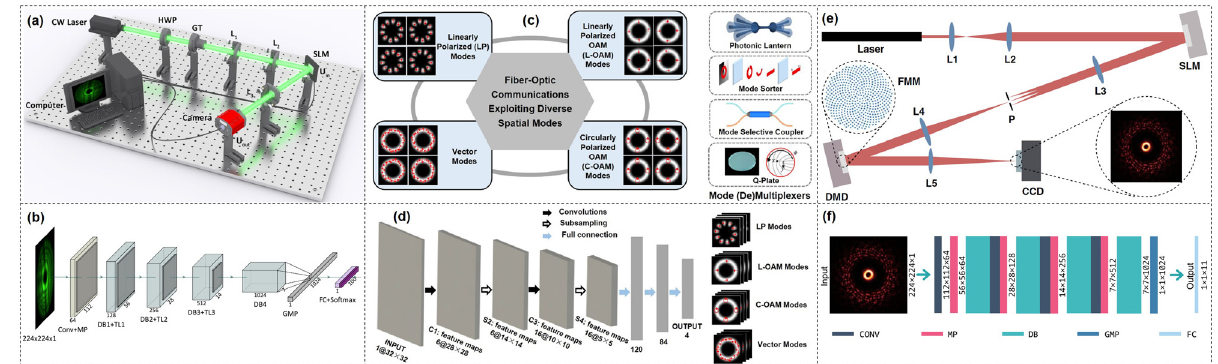
Figure 27: Intelligent spatial modes recognition in optical communications. (a) Experimental setup of OAM-recognition neuron network (ORNN) with deep learning. (b) Sketch map of the ORNN architecture to recognize OAM beams. Conv: convolution layer; MP: max pooling layer; DB: dense block; TL: transition layer; GMP: global max pooling layer; FC: